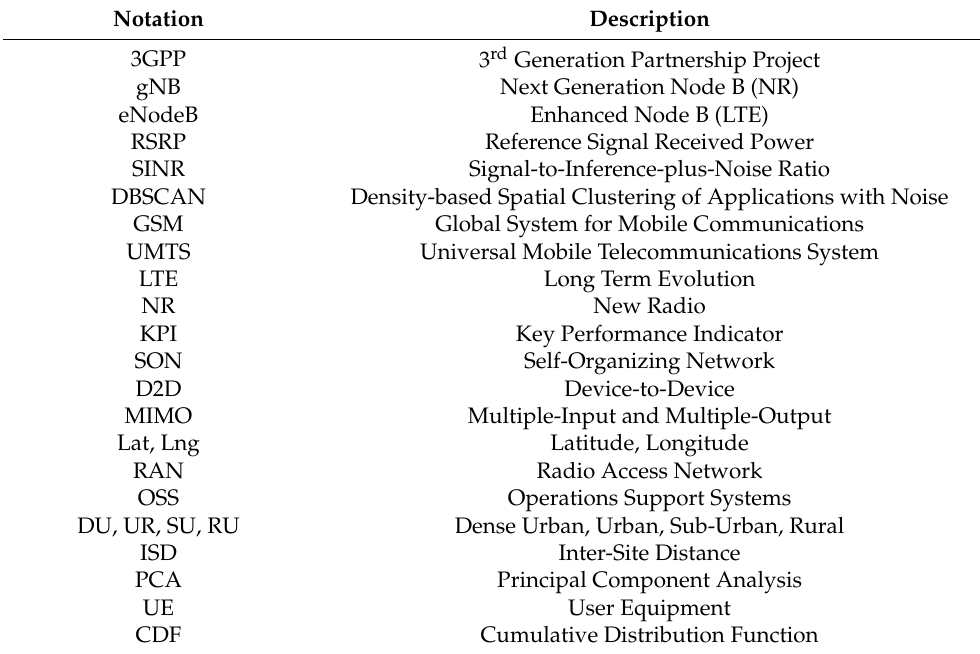
Table 1. Table of notations used in this